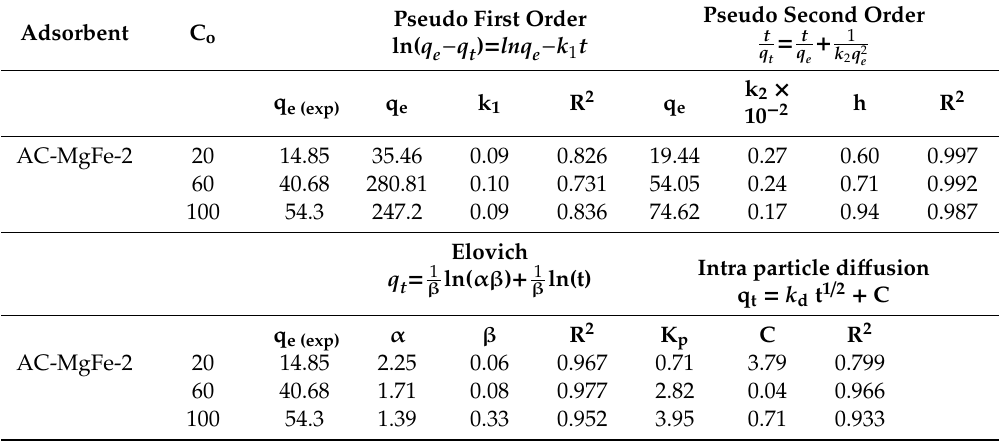
Table 2. Parameters of pseudo-first, pseudo-second-order, elovich, and intra particle di ff usion kinetic models for phenol removal onto AC–MgFe-2